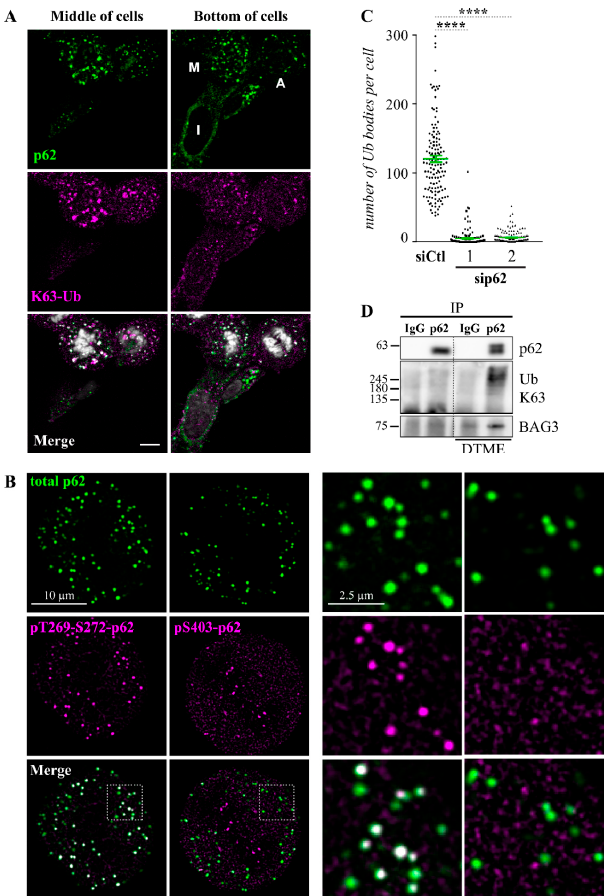
Figure 5. The sequestosome p62 forms mitotic inclusion bodies (MIBS) enriched in CDK1-phosphorylated p62 and K63 polyubiquitin chains. ( A ) Representative single-plane confocal images of HeLa cells synchronized in mitosis by a double thymidine block, showing staining of p62, K63 polyubiquitin (K63-Ub), and DNA (Hoechst) in cells at different mitotic stages compared to a cell in interphase; M: metaphase; A: anaphase; I: interphase. Bar: 10 µ m. ( B ) Deconvolved single-plane confocal images of a representative HeLa cell at metaphase from a non-synchronized cell popula- tion, showing staining of pT269-S272-p62 (CDK1-induced), pS403-p62 (stress-induced), and total p62. Enlarged views of the boxed regions emphasize MIBS spherical shape and enrichment in p62 phosphorylated at mitotic sites (T269-S272) but not at the canonical stress-induced site (S403); Bars: 10 µ m or 2.5 µ m. ( C ) Quantification of polyubiquitin clusters in non-synchronized HeLa cells at prometaphase-metaphase. Cells were transfected with control siRNA or p62-specific siRNAs and stained using anti- α -tubulin and anti-ubiquitin antibodies, means ± SE from 102 to 136 cells from at least 4 independent experiments. Statistical significance was analyzed using the Kruskal–Wallis test and Dunn (cid:48) s multiple comparisons: ****, p < 0.0001. See also Figure S5A for the representative pheno- type in p62-depleted cells and Figure S5B for MIBS staining in other cell types. ( D ) p62 or control IPs were prepared using anti-p62 or rabbit IgG, respectively, from mitotic HeLa cells (nocodazole-treated and recovered by a mitotic shake-off); cells were treated with a reversible crosslinker (DTME) or the vehicle prior to cell lysis and p62 IPs were analyzed by Western blot using anti-p62, anti-BAG3, and anti-K63